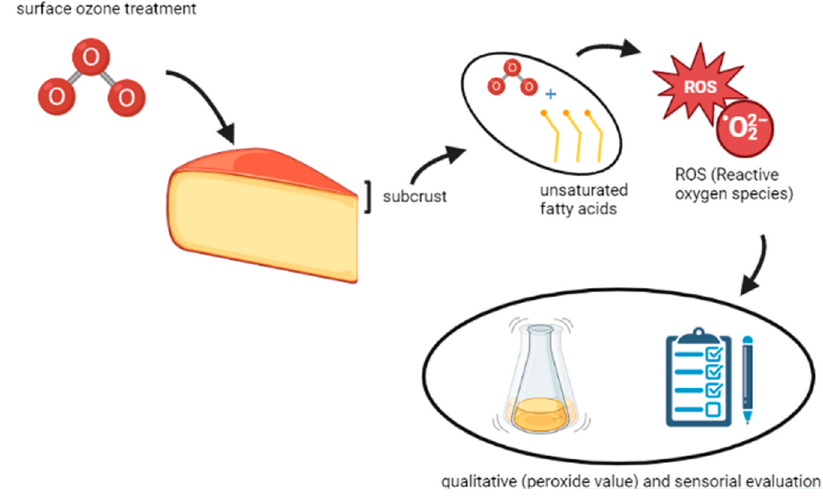
Figure 4. Mechanism of sensory alterations by ozone.